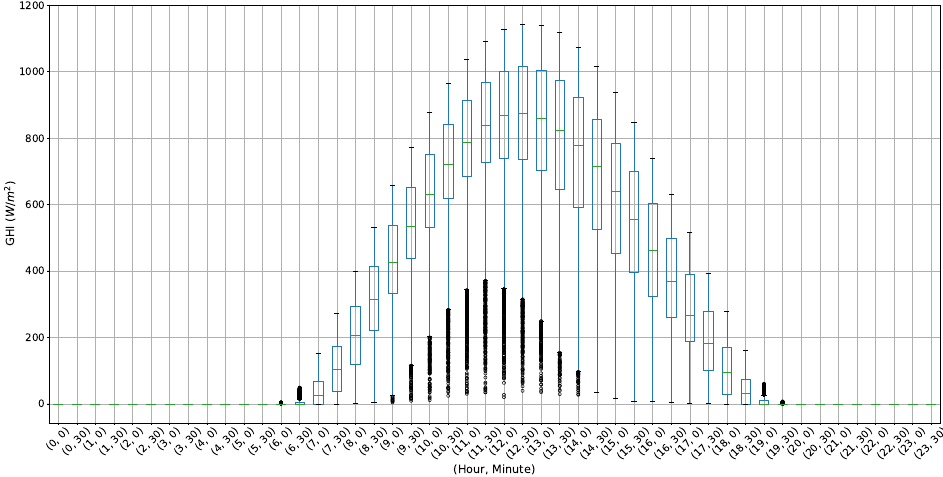
Figure 4. Boxplot for every intra-day time step from 2007 to 2019.